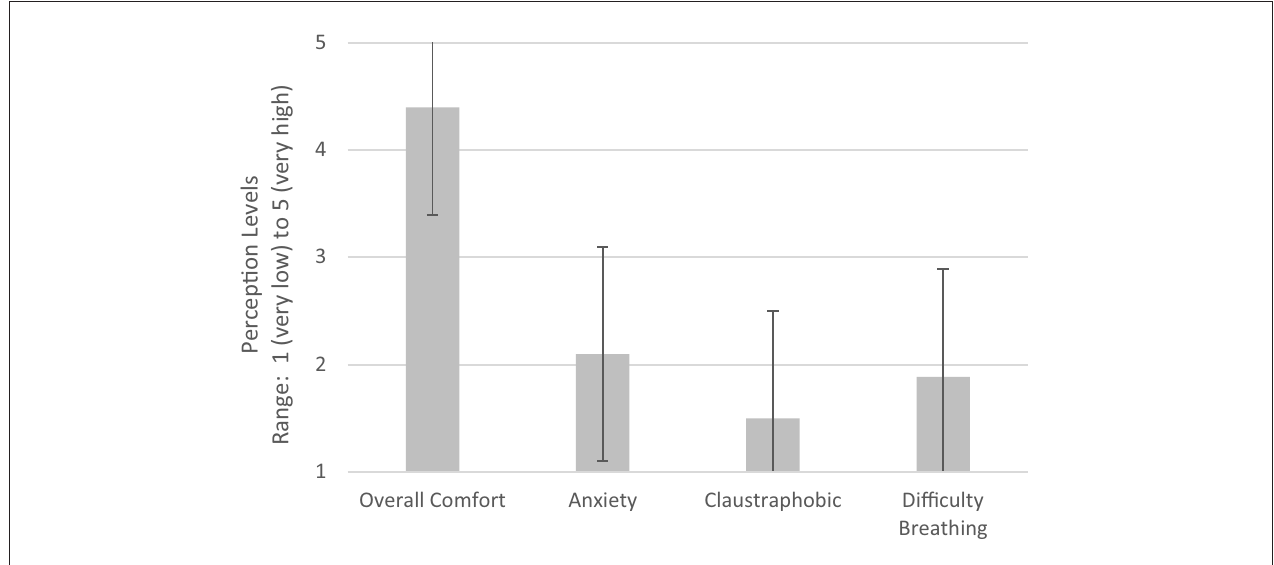
FIGURE 9 | User tolerability of device. Perceptions of users during CPAP delivery using LeVe. Error bars indicate ± 1 SD. 5: Very high, 4: High, 3: Moderate, 2: Low, and 1: Very low.